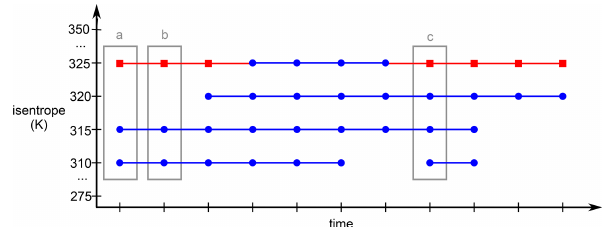
Figure 2. Schematic visualization of the construction of a 3D PV cutoff track from all overlapping isentropic 2D PV cutoff tracks. Isentropic 2D tracks making up the final 3D track are marked with blue lines and dots, and the isentropic tracks that are removed with red lines and squares. See text for a detailed